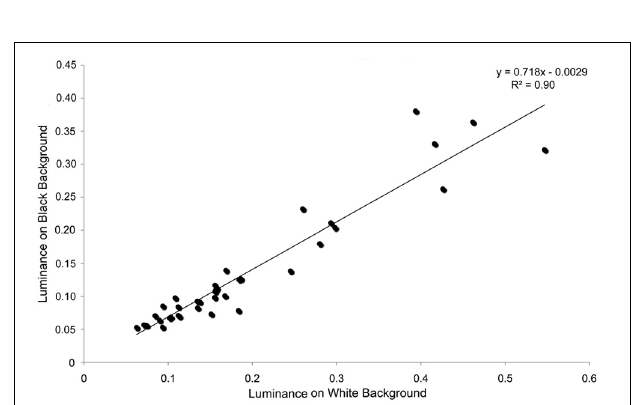
FIGURE 3 | Individual changes in luminance in experiment 1 with crabs on black and white backgrounds. Each individual line represents one individual, showing that individuals vary greatly in overall luminance, and the level of change between the two backgrounds (slope of the lines).